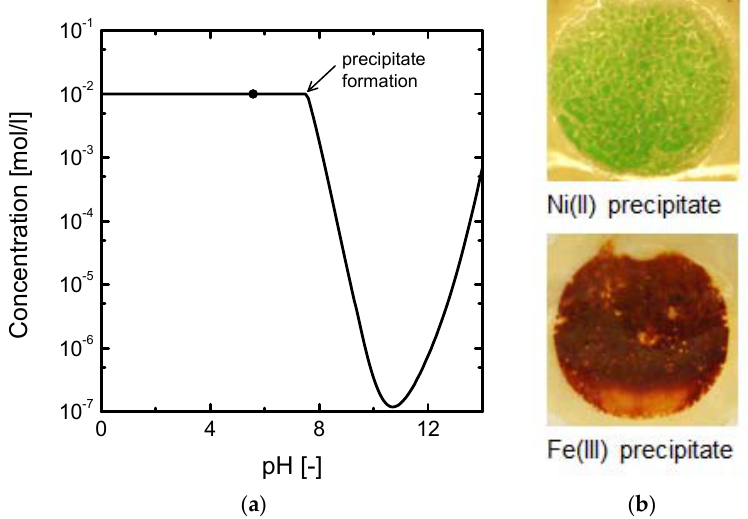
Figure 4. ( a ) Precipitation diagram of 10 − 2 M NiSO 4 solutions. The dot represents the initial pH under equilibrium conditions. ( b ) Pictures of the membrane surface facing the diluate compartment after the formation of precipitates of Ni(II) and Fe(III).